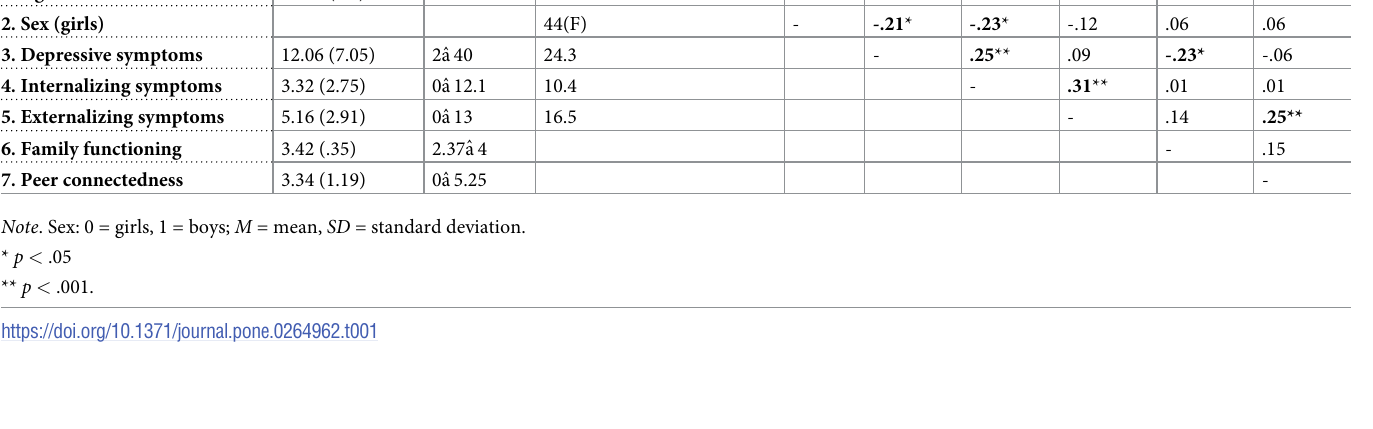
Table 1. Descriptives and correlations amongst the variables in the study (N between 115a ˆ 109). M (SD) Range % above clinical